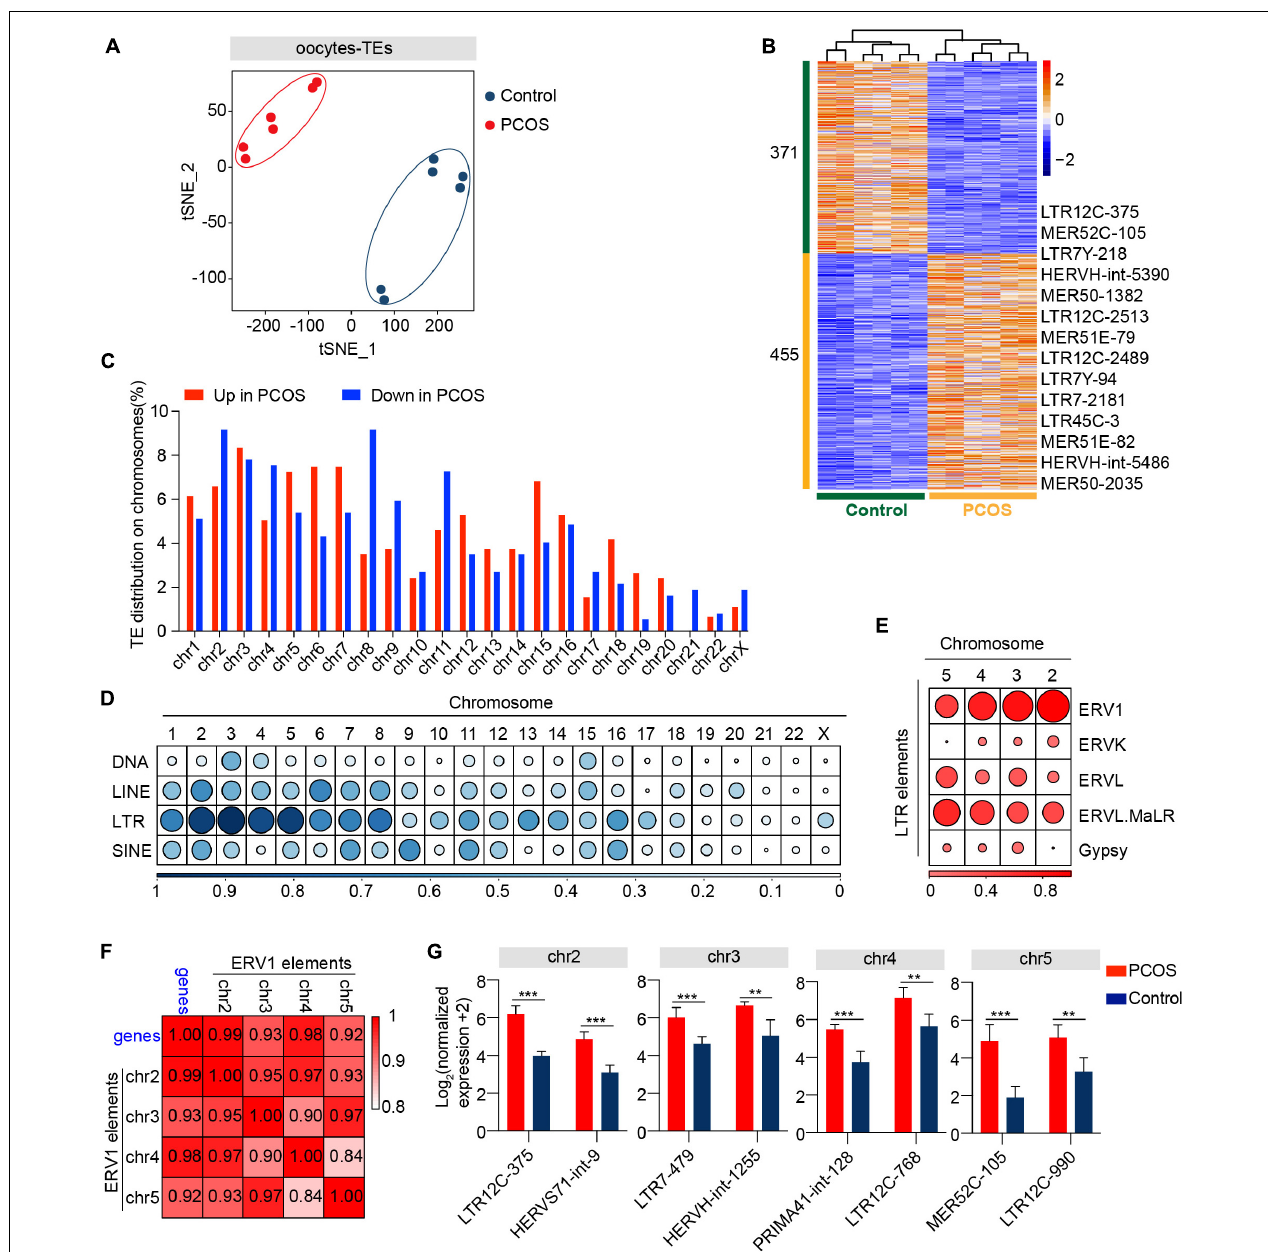
FIGURE 4 | Retrotransposons in PCOS and control oocytes. (A) Visualization of transposable element (TE) expression of oocytes by t-SNE, showing two clusters, including one for PCOS oocytes and the other for control oocytes ( n = 6). Each dot corresponds to one oocyte, clustered by color. (B) Heat map of differentially expressed TEs (DETs) in oocytes between PCOS and control. The number of up-DETs is 455 and down-DETs is 371. The color key from blue to red indicates the relative gene expression levels from low to high, respectively. (C) The proportion of differentially expressed TEs in each chromosome. The red bars represent the percentage of upregulated TEs, and the blue bars represent the percentage of downregulated TEs. (D) Proportion of DETs classified by repeat classes on different chromosomes. Dots from large to small or color from dark to light represents the proportion from high to low. (E) Proportion of differentially expressed long terminal repeat (LTR) elements classified by repeat super-families on chromosomes 2, 3, 4, and 5. (F) Correlation between the expression levels of ERV1 elements on chromosomes 2, 3, 4, and 5 and of protein-coding genes in PCOS oocytes. The correlation coefficient is shown on the plot. (G) The expression levels of